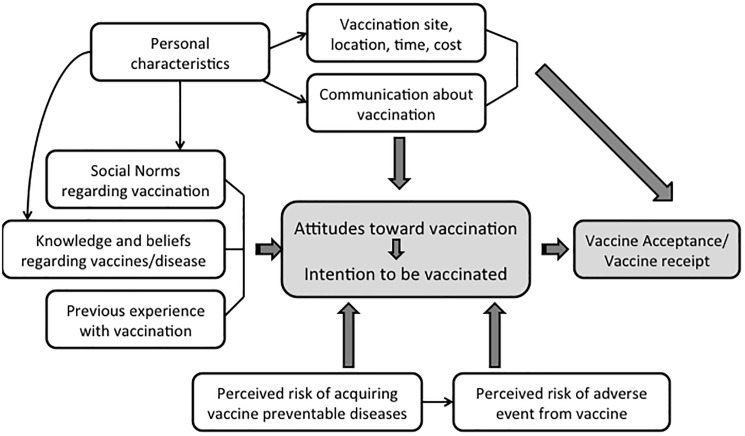
Conceptual model demonstrating the interrelationship of factors that drives attitudes toward vaccination.